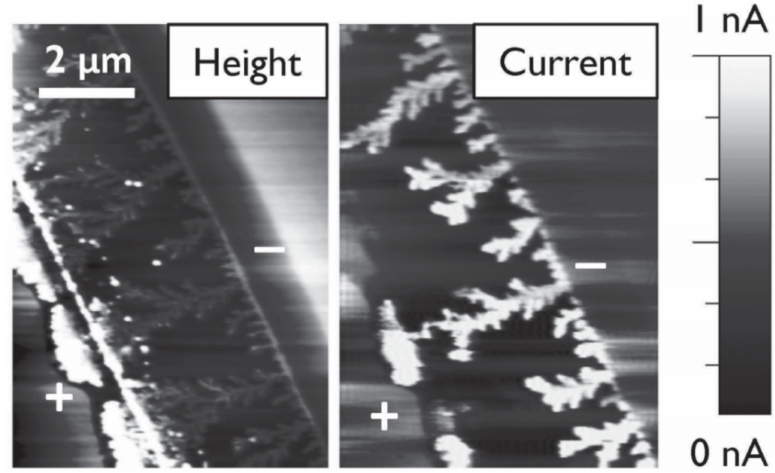
Figure 13. An example of an atomic force microscopy (AFM) image of melanin films and the beautiful gold dendrites. On the left is an image measuring the height of the film and on the left is a conductive AFM image. Reprinted with permission from Wünsche et al. [142]. © 2013 John Wiley & Sons, Inc. (Hoboken, NJ, USA).